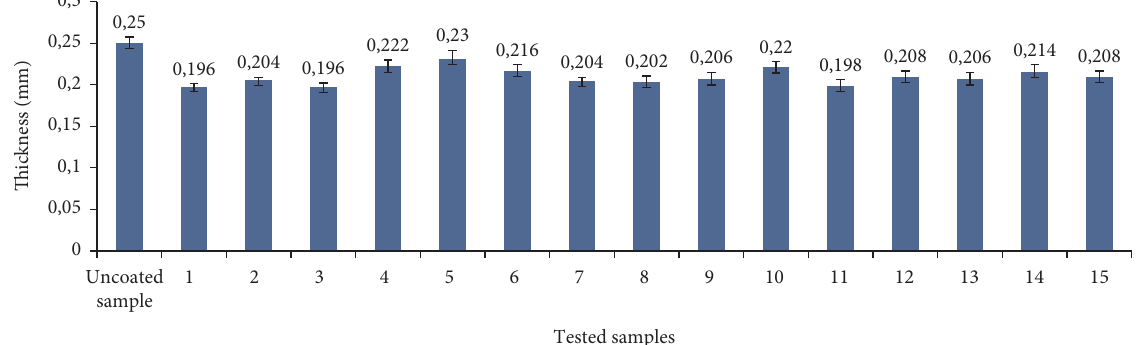
Figure 2: Evolution of thickness values for the uncoated and coated woven